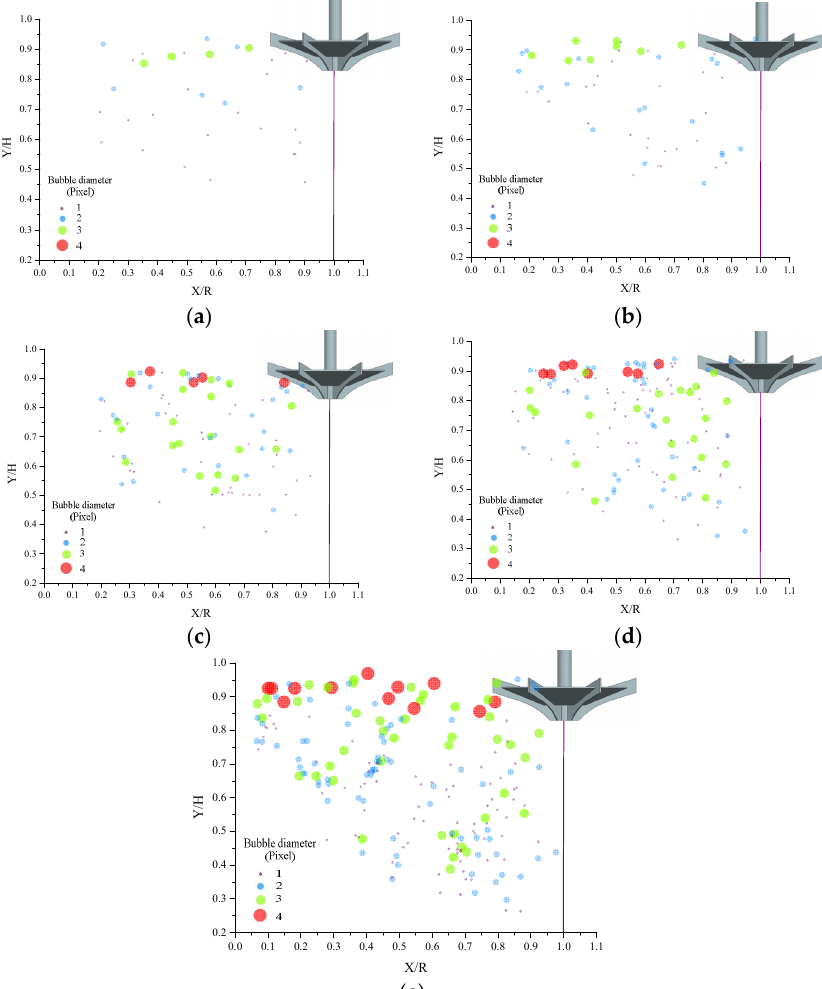
Figure 7. Bubble distribution at different rotational speeds. ( a ) 200 rpm; ( b ) 225 rpm; ( c ) 250 rpm; ( d ) 275 rpm; ( e ) 300 rpm.